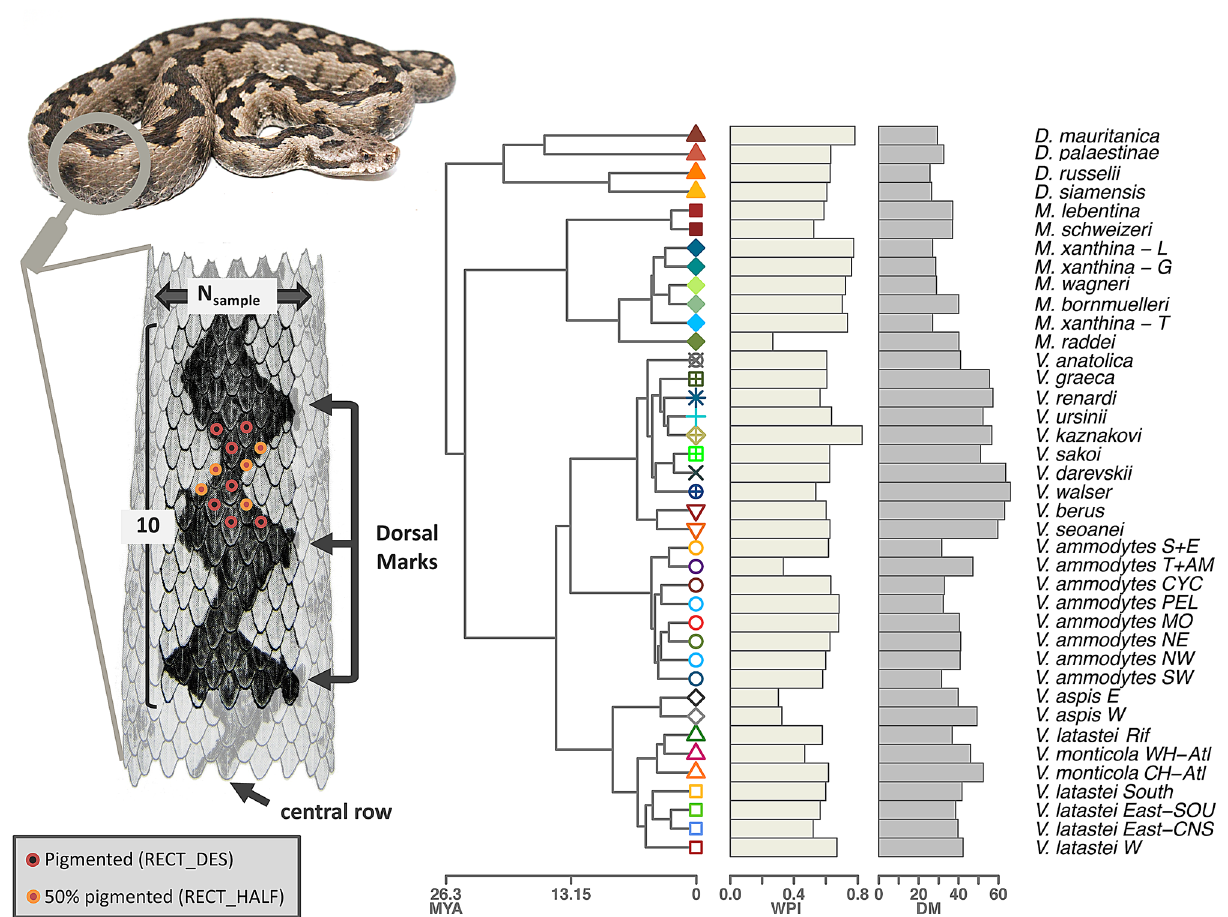
Figure 1. Schematic representation of the weighed pigmentation index (WPI) and the position of dorsal marks counted throughout the entire length of the body (DM), phylogenetic tree used for evolutionary analyses, and macroevolutionary variation in both traits across evolutionary units within Eurasian vipers. See Table S1 for evolutionary unit names.